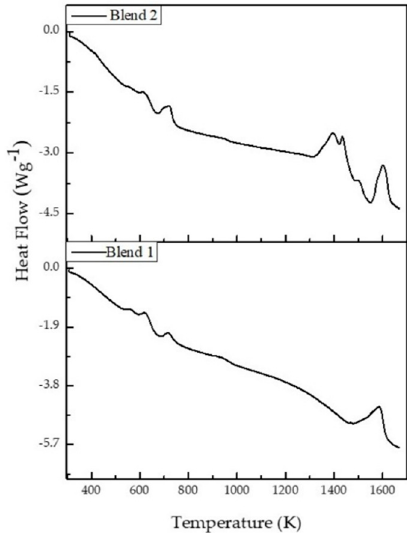
Figure 3. Typical DSC curves of Blends 1 and 2 in an Ar atmosphere .